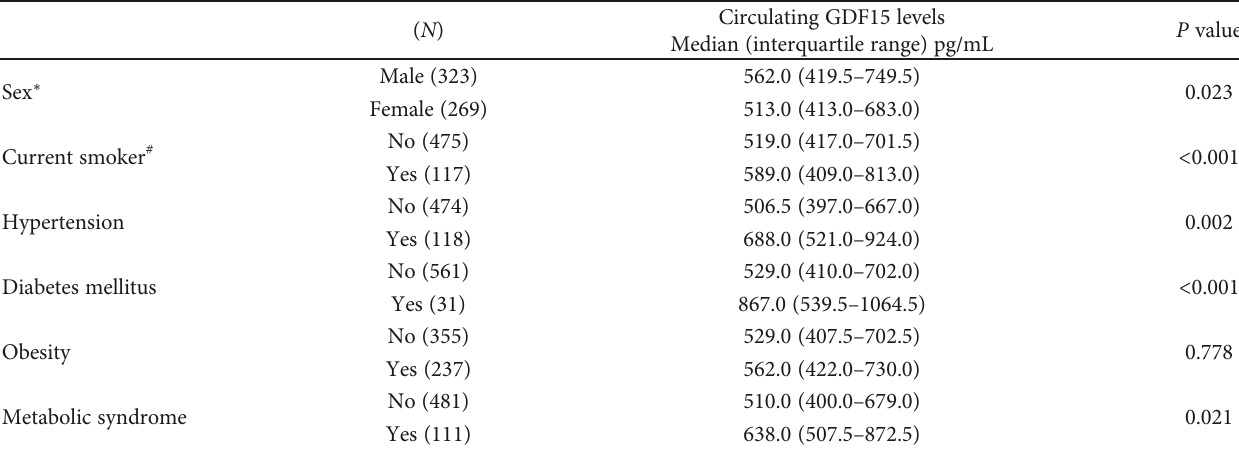
Table 5: Circulating growth di ff erentiation factor 15 ( GDF15 ) levels according to the cardiovascular risk factors in subjects from the healthy cohort.